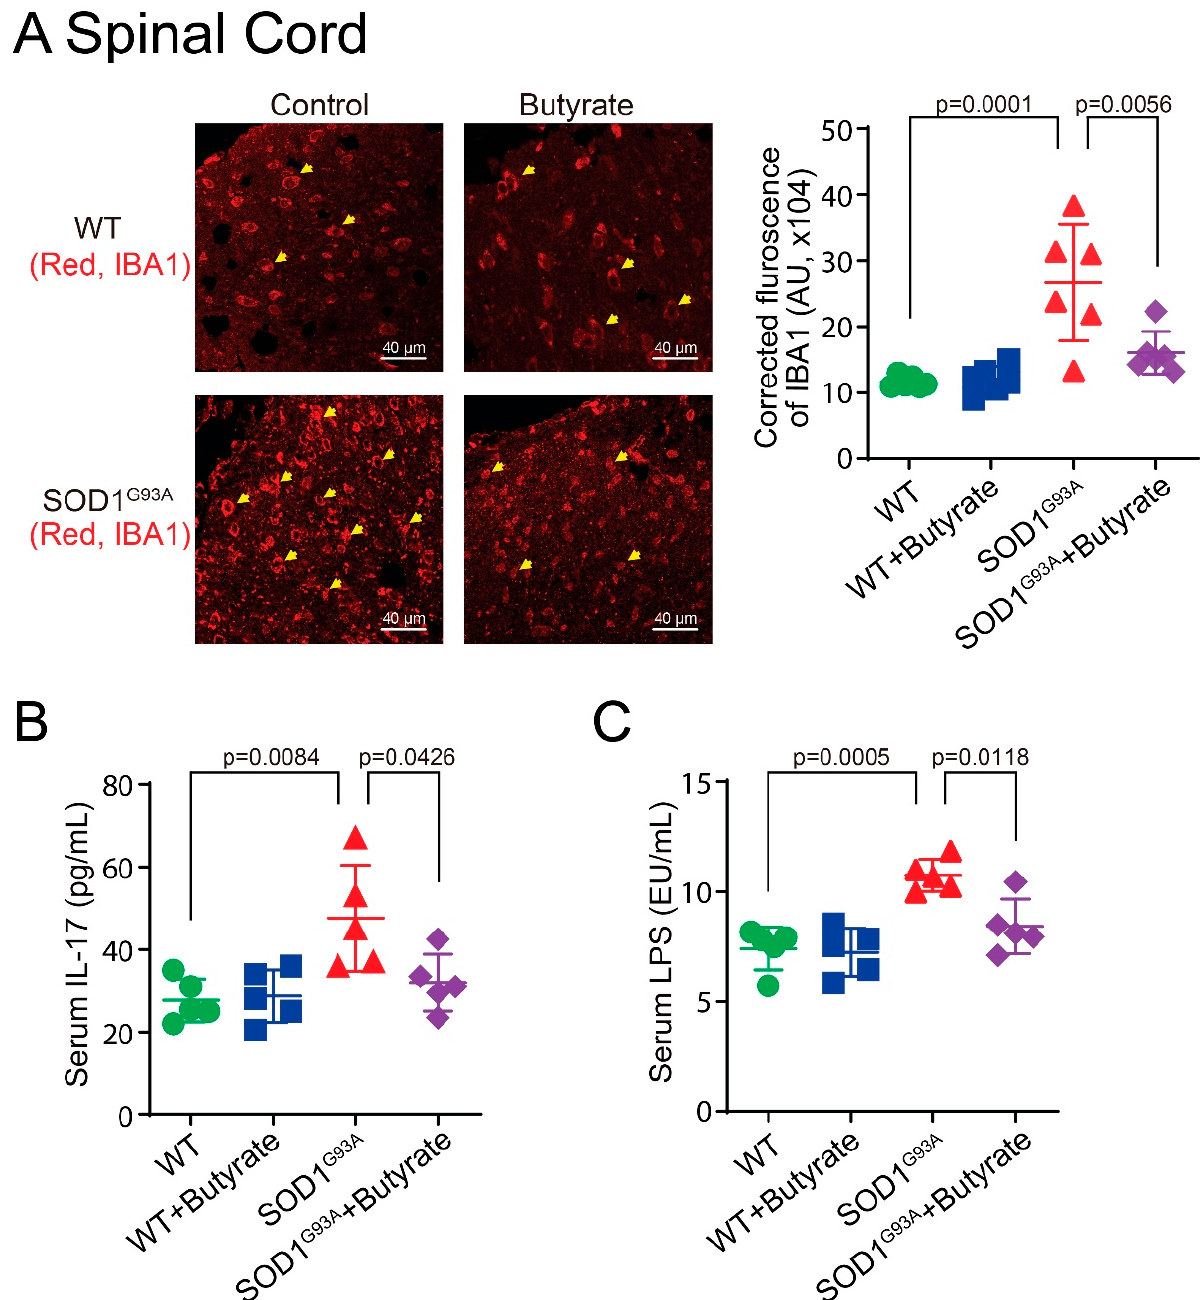
Figure 8. Butyrate treatment led to reduced lumbar spine IBA1 expression and reduced serum IL-17 and LPS expression in SOD1 G93A mice. ( A ) Decreased IBA1 expression in lumbar spine of SOD1 G93A mice with butyrate treatment compared with the WT group. Male or female SOD1 G93A mice were treated with or without 2% butyrate in drinking water starting with mice aged 9 weeks to 15 weeks. At the age of 15 weeks, mice were sacrificed, and blood and tissues were collected. Images are from a single experiment and are representative of 6 mice per group. (Data are expressed as mean ± SD. N = 6, one-way ANOVA test). ( B ) IL-17 was significantly lower in the serum of SOD1 G93A mice with butyrate treatment compared with the WT group. (Data are expressed as mean ± SD. N = 5, one-way ANOVA test). ( C ) LPS was significantly lower in the serum of SOD1 G93A mice with butyrate treatment compared with the WT group. (Data are expressed as mean ± SD. N = 5, one-way ANOVA test). The p -values used in the figures are the adjusted p -values given by the Tukey